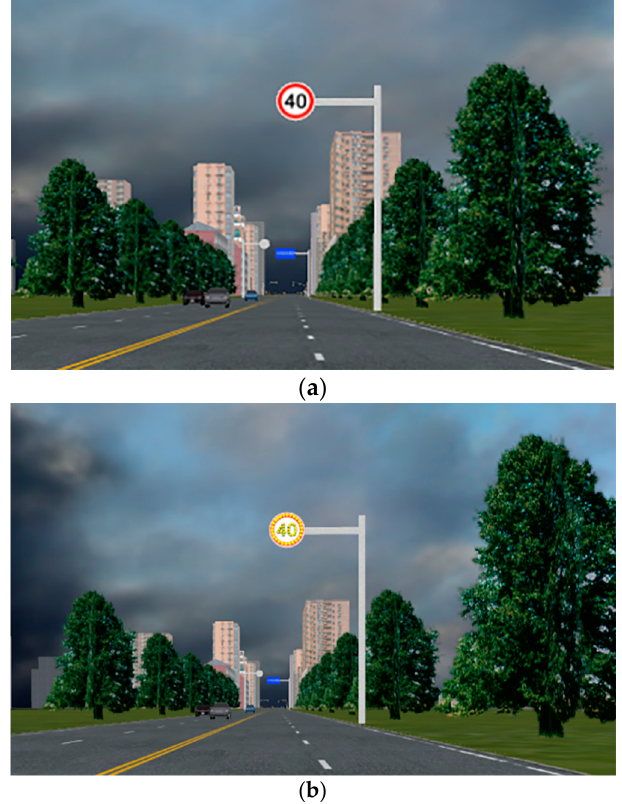
Figure 2. Snapshots of the traditional and lit speed limit signs. ( a ) The traditional speed limit sign; ( b ) the lit speed limit sign.